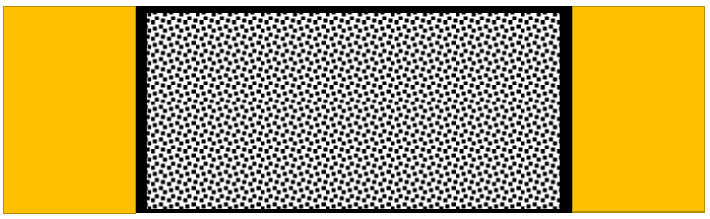
Figure 8. Speckle pattern in Digital Image Correlation (DIC).